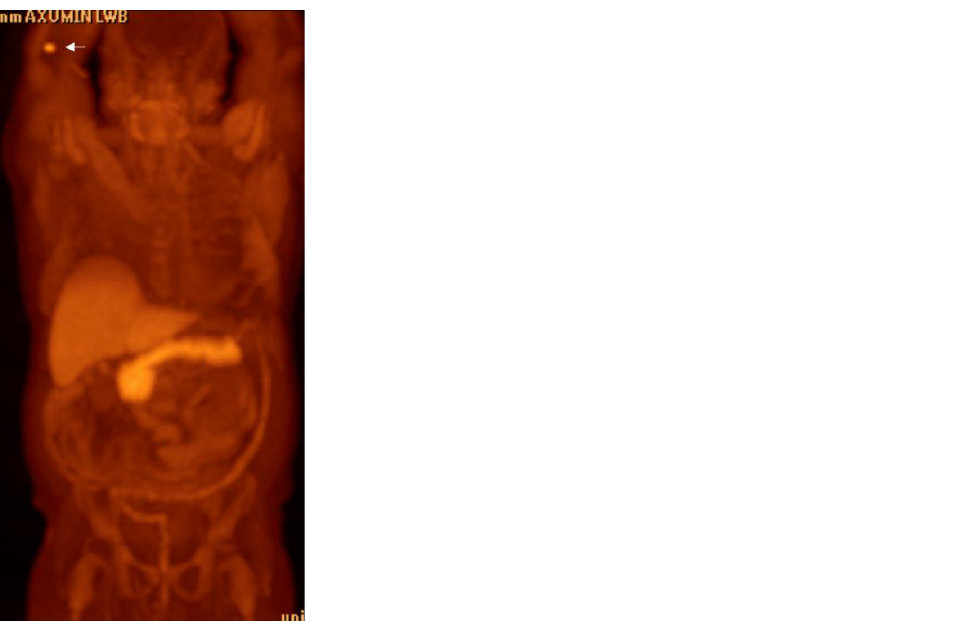
Figure 4. Axumin MIP image shows normal physiologic uptake within the pancreas (most intense), liver, salivary glands, small bowel, red marrow, and muscle. Note that the focus of increased uptake at the injection site in the right antecubital fossa (arrow).